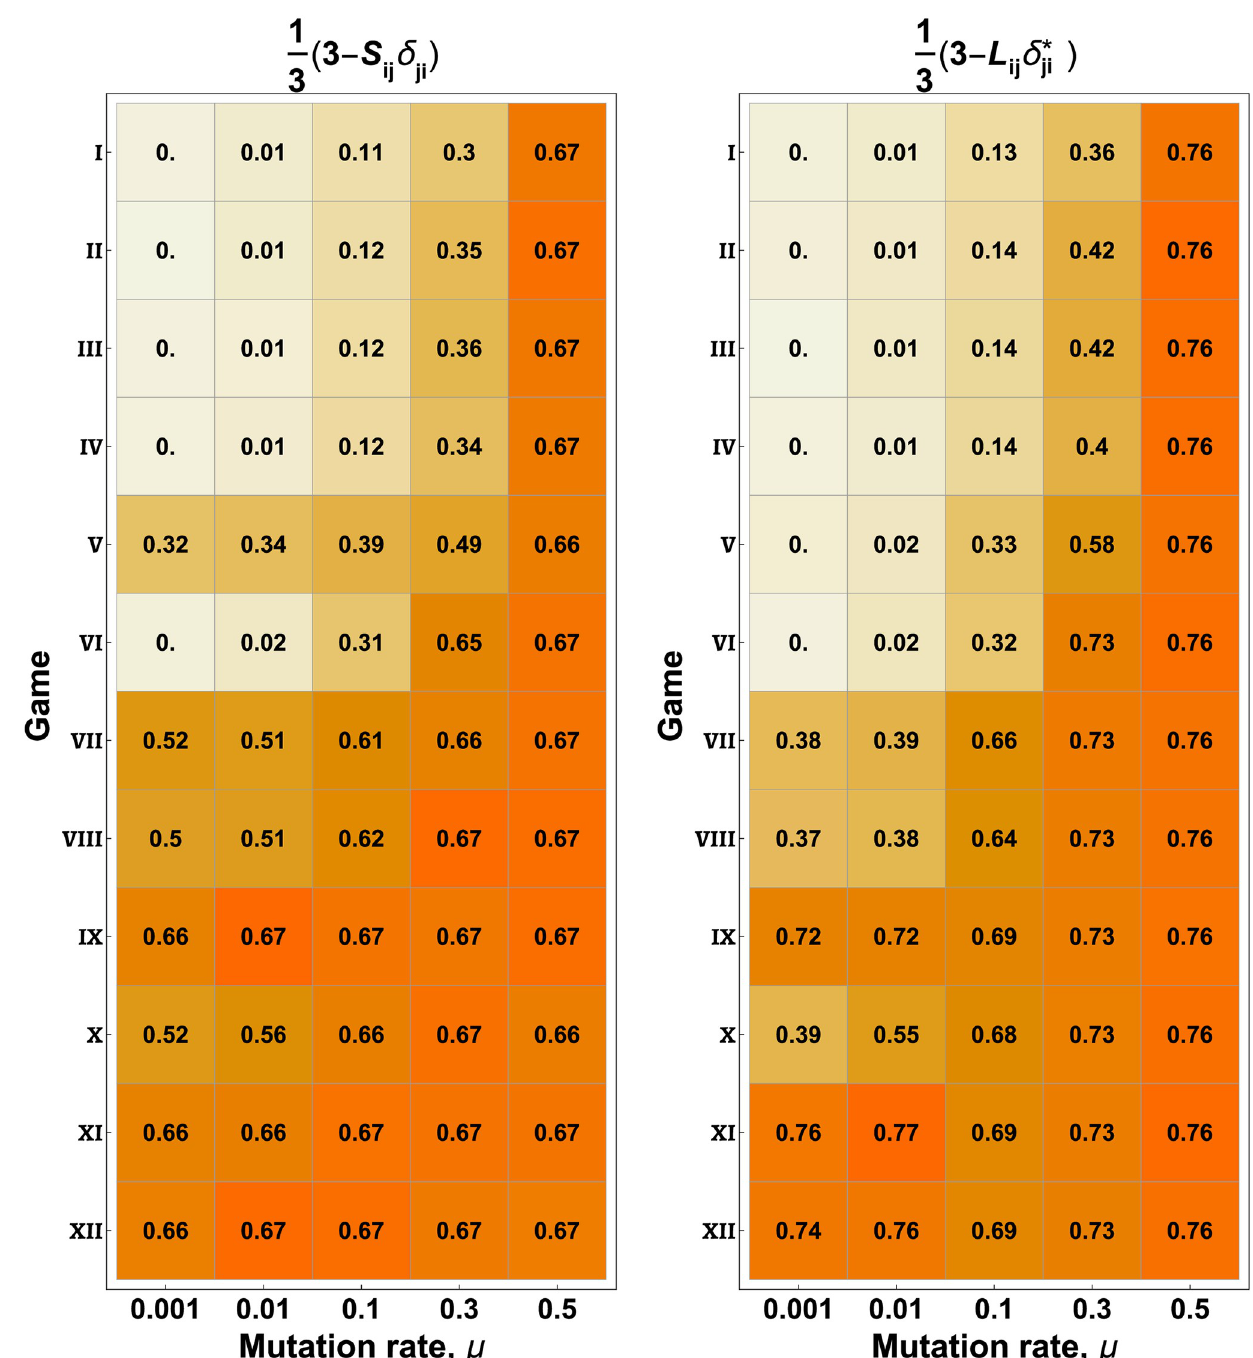
Fig 4. Original meaning of words is lost with increasing misalignment. ( left ): A natural measure for long-term language change is with what probability speakers use word x for state 0, y for 1/2, and z for 1 at the end of the game, since this is the fully-informative language which constitutes the initial condition for all players. This can be written as a “percentage change” in the form 1 − ( S ij δ ji )/3, where S P matrix and L ¼ Q ð n Þ ij = N is the population-averaged listening matrix (and Einstein summation conventions have been implemented). ( Right ): A similar ij n is understood to be the 3 × 5 matrix with d � metric for the listeners. d � ii asymmetric game, however the symmetric game shows nearly identical results, see Fig I in S1 File. Note that the upper bounds of 2/3 (left) and 4/5 (right) reflect two different situations—in the limit of high μ , each word becomes equiprobable for each state (probability 1/3 for speakers, so Tr ( S ) = 1, and 1/5 for listeners, so L d � ¼ 3 = 5 ); in the limit of high Γ , one-word languages come to dominate (Fig 2), so one diagonal element of S is always equal to 1 and the rest ij ji to